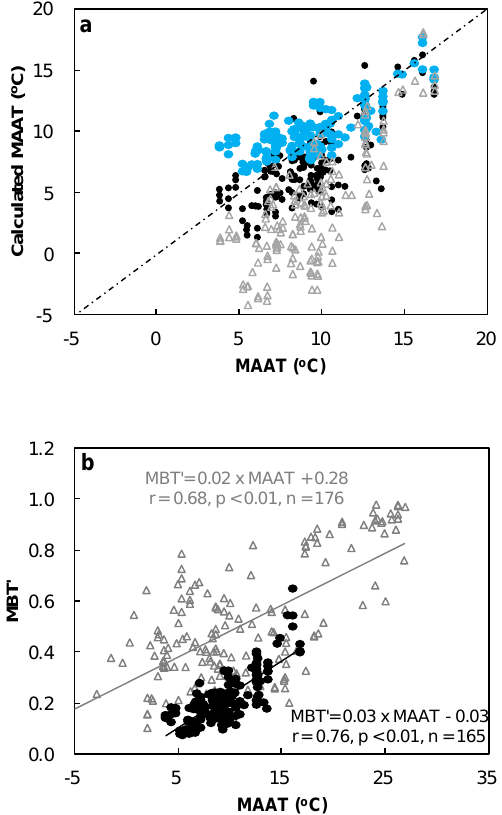
Figure 9. Linear regression plots of (a) reconstructed MAAT vs. meteorological MAAT and (b) MBT’ vs. meteorological MAAT. In (a) , calculated MAAT based on the global MBT’ / CBT calibra- tion and MBT’ / pH calibration (Peterse et al., 2012) is indicated in grey triangles and dark solid circles, respectively, while calculated MAAT based on the Chinese SSM calibration (Yang et al., 2014a) is indicated in blue solid circles. In (b) , grey triangles indicate data compiled by Peterse et al. (2012) while solid circles represent Chi- nese alkaline soil samples (97 from this study and 78 from Yang et al., 2012; Xie et al., 2012; and Yang et al.,